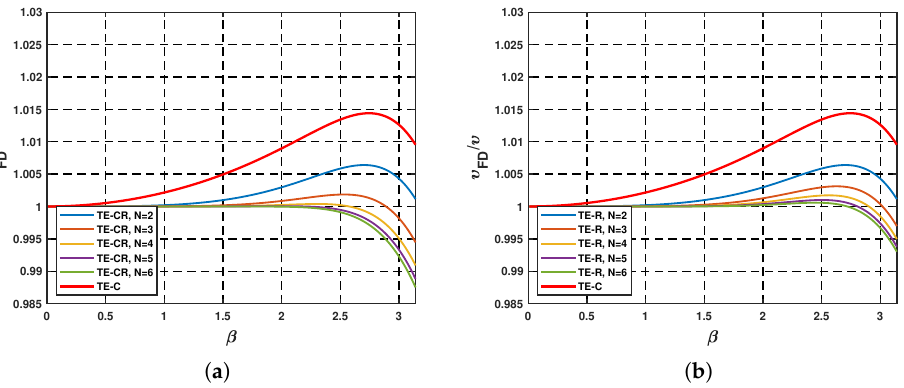
Figure 3. Dispersion curves of TE-CR and TE-R methods with different orders N . Here, υ = 1500 (m/s), h = 6 (m), M = 8, and propagation angle α = π /16: ( a ) TE-CR method and ( b ) TE-R